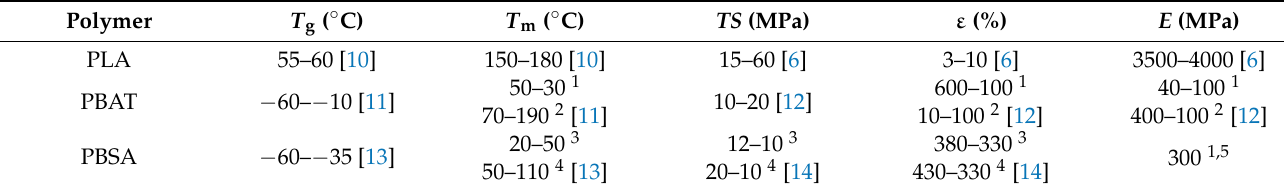
Table 1. Thermal and mechanical properties (glass transition temperature, T g ; melting temperature, T m ; tensile strength, TS ; elongation at break, ε ; elastic modulus, E ) of PLA, PBAT, and PBSA.